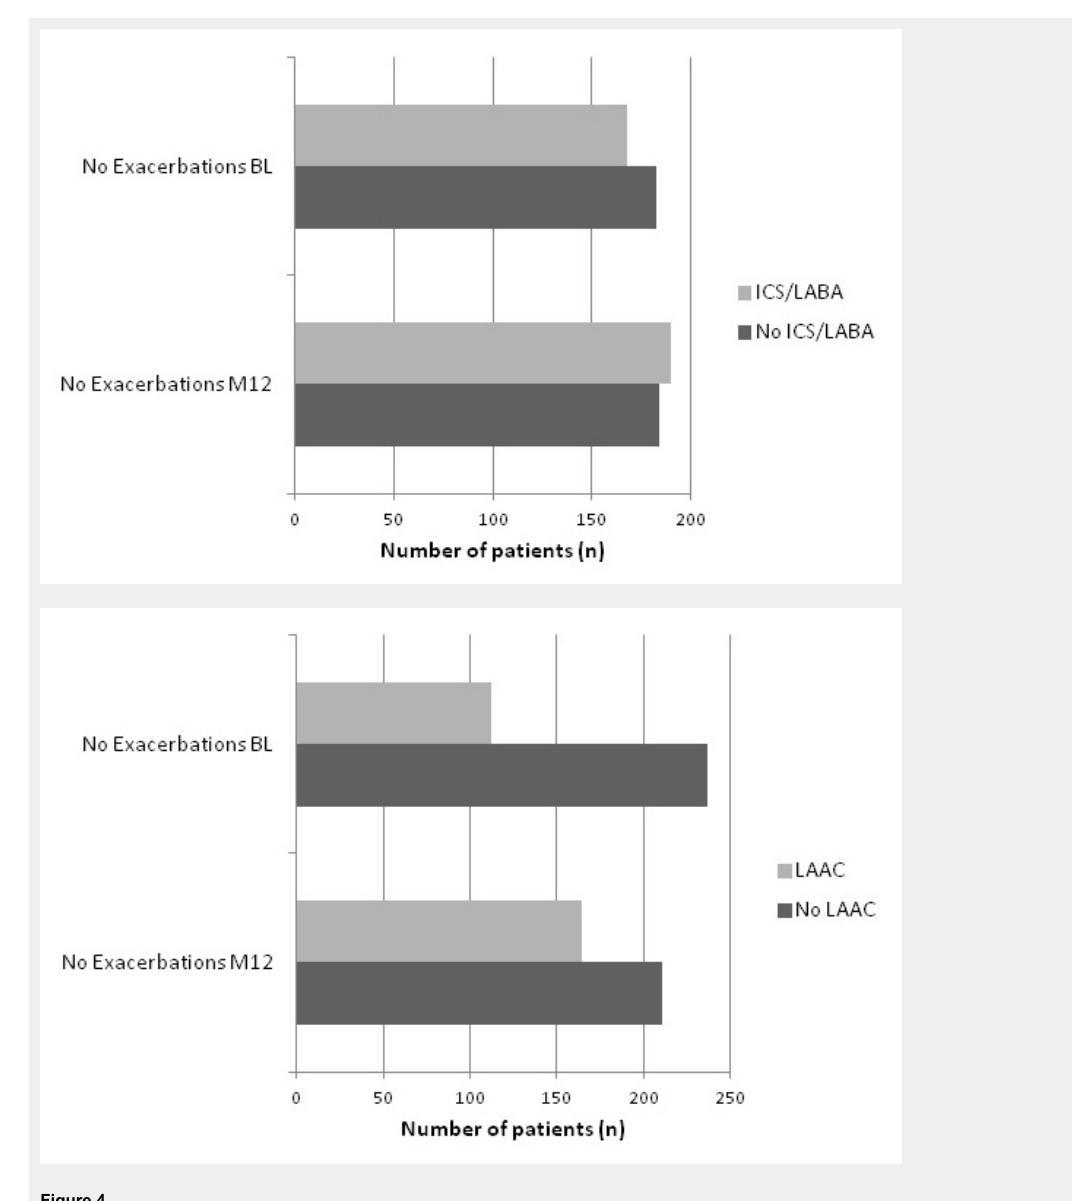
Figure 4 Influence of a.) combination therapy b.) LAAC on exacerbation rate. a.) Proportion of patients inhaling combined therapy or not at BL visit in relation to their exacerbations compared to patients inhaling combined therapy at M12 in relation to their exacerbations: (Significant Increase of exacerbation free patients in the group inhaling combined therapy: p = 0.018, OR = 0.39 CI: 0.39–0.71). b.) Proportion of patients inhaling LAAC or not at BL visit in relation to their exacerbations compared to patients inhaling LAAC at M12 in relation to their exacerbations: (significant Increase of exacerbation free patients in the group inhaling LAAC: p = 0.0011, OR = 0.37 CI: